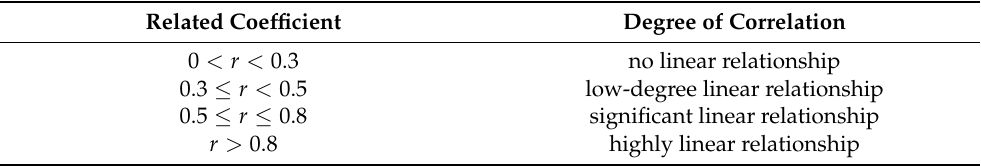
Table 1. Criteria for judging the degree of relevance. Related Coefficient Degree of